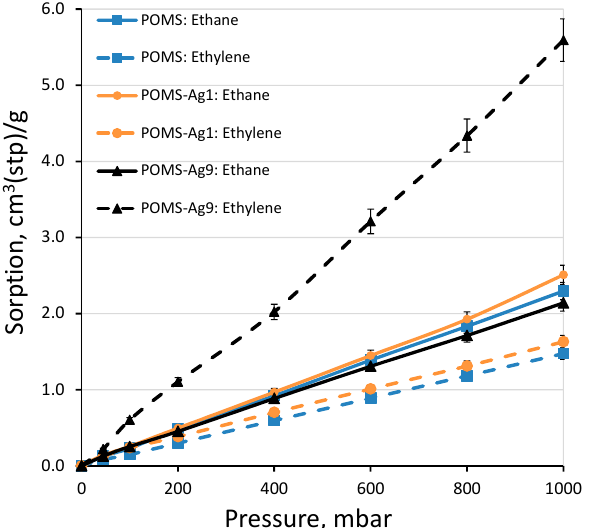
Figure 7. Sorption isotherms of ethane (solid line) and ethylene (dashed line) in POMS (square), POMS-Ag1 (circle), and POMS-Ag9 (triangle) at 35 °C.